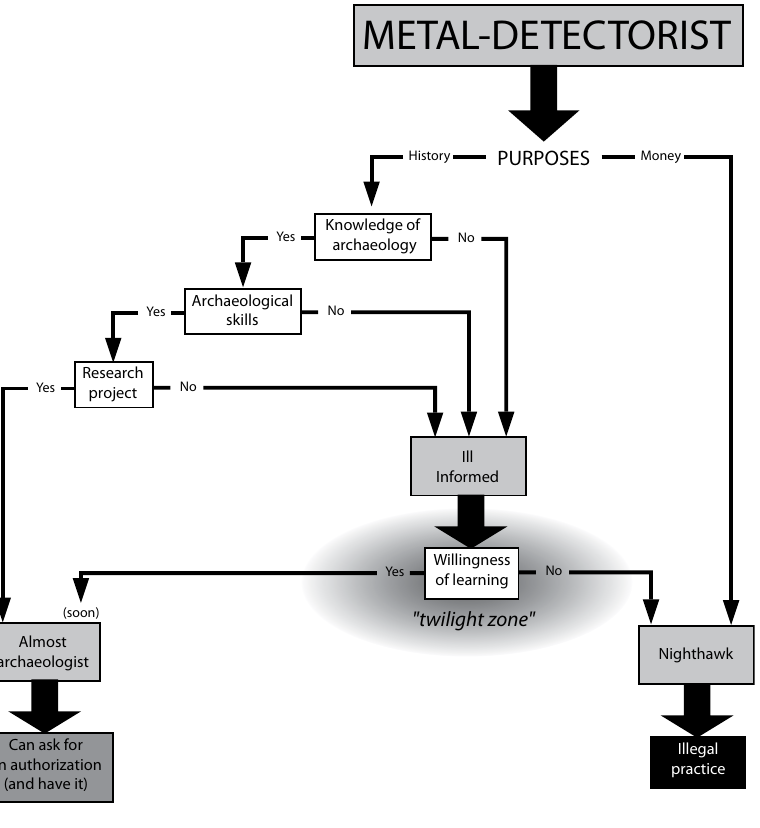
Figure 1: The three types of